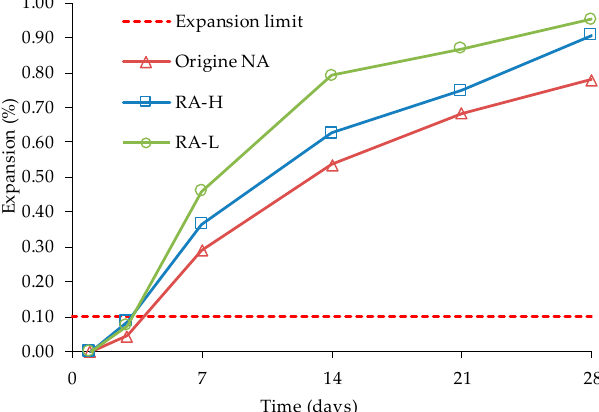
Figure 12. Expansion behaviour of RA and NA according ASTM C1260, adapted from [84].